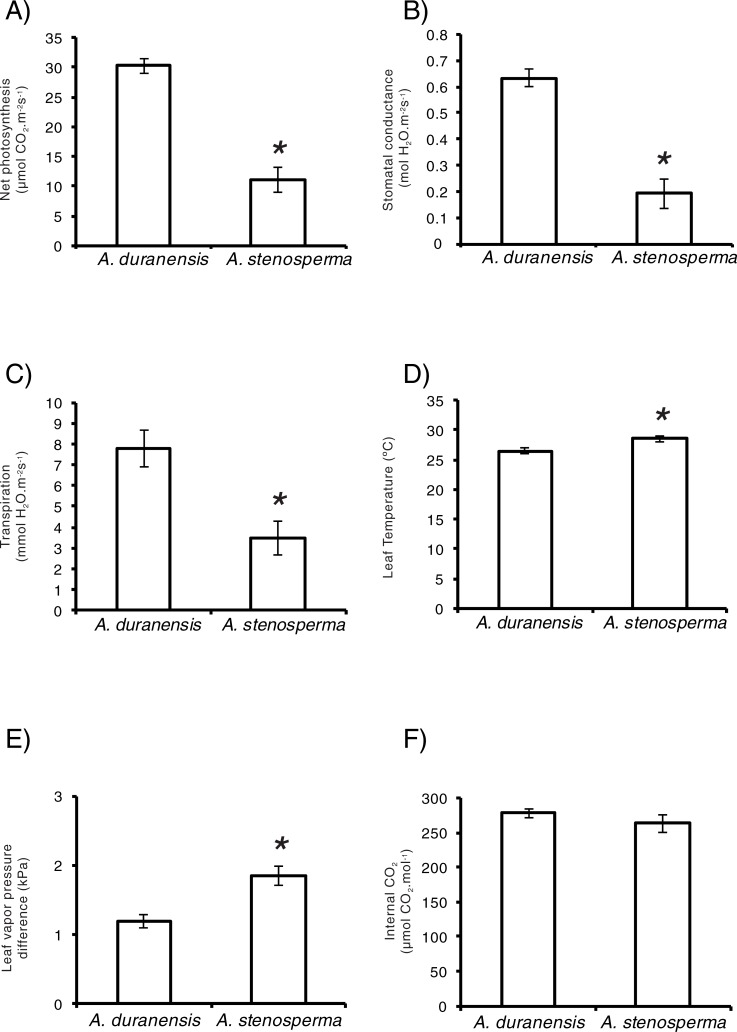
Physiological analysis of Arachis spp. plants during the early stages of dehydration.A) Photosynthetic rate; B) Stomatal conductance; C) Transpiration rate; D) Leaf temperature; E) Leaf vapor pressure deficit; and F) Internal CO2 concentration of A. duranensis and A. stenosperma plants subjected to dehydration. Data represent averages calculated over the early stages (0, 25 and 50 min) of the drought imposition and standard error. Statistically significant differences (n = 3, Student’s t-test, p<0.05) are indicated by asterisk.